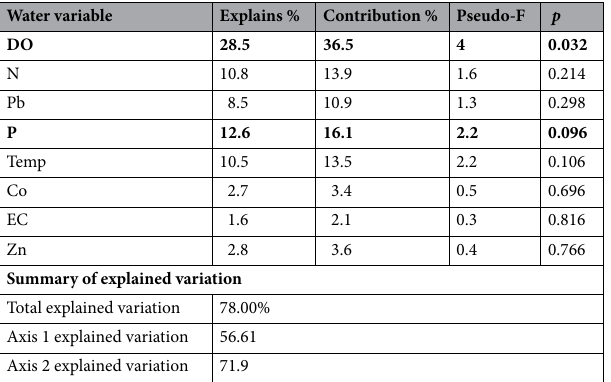
Table 4. Forward selection results of the constrained CCA and summary of the explained variation. The most important explanatory variables, explain % and contribution % are highlighted in